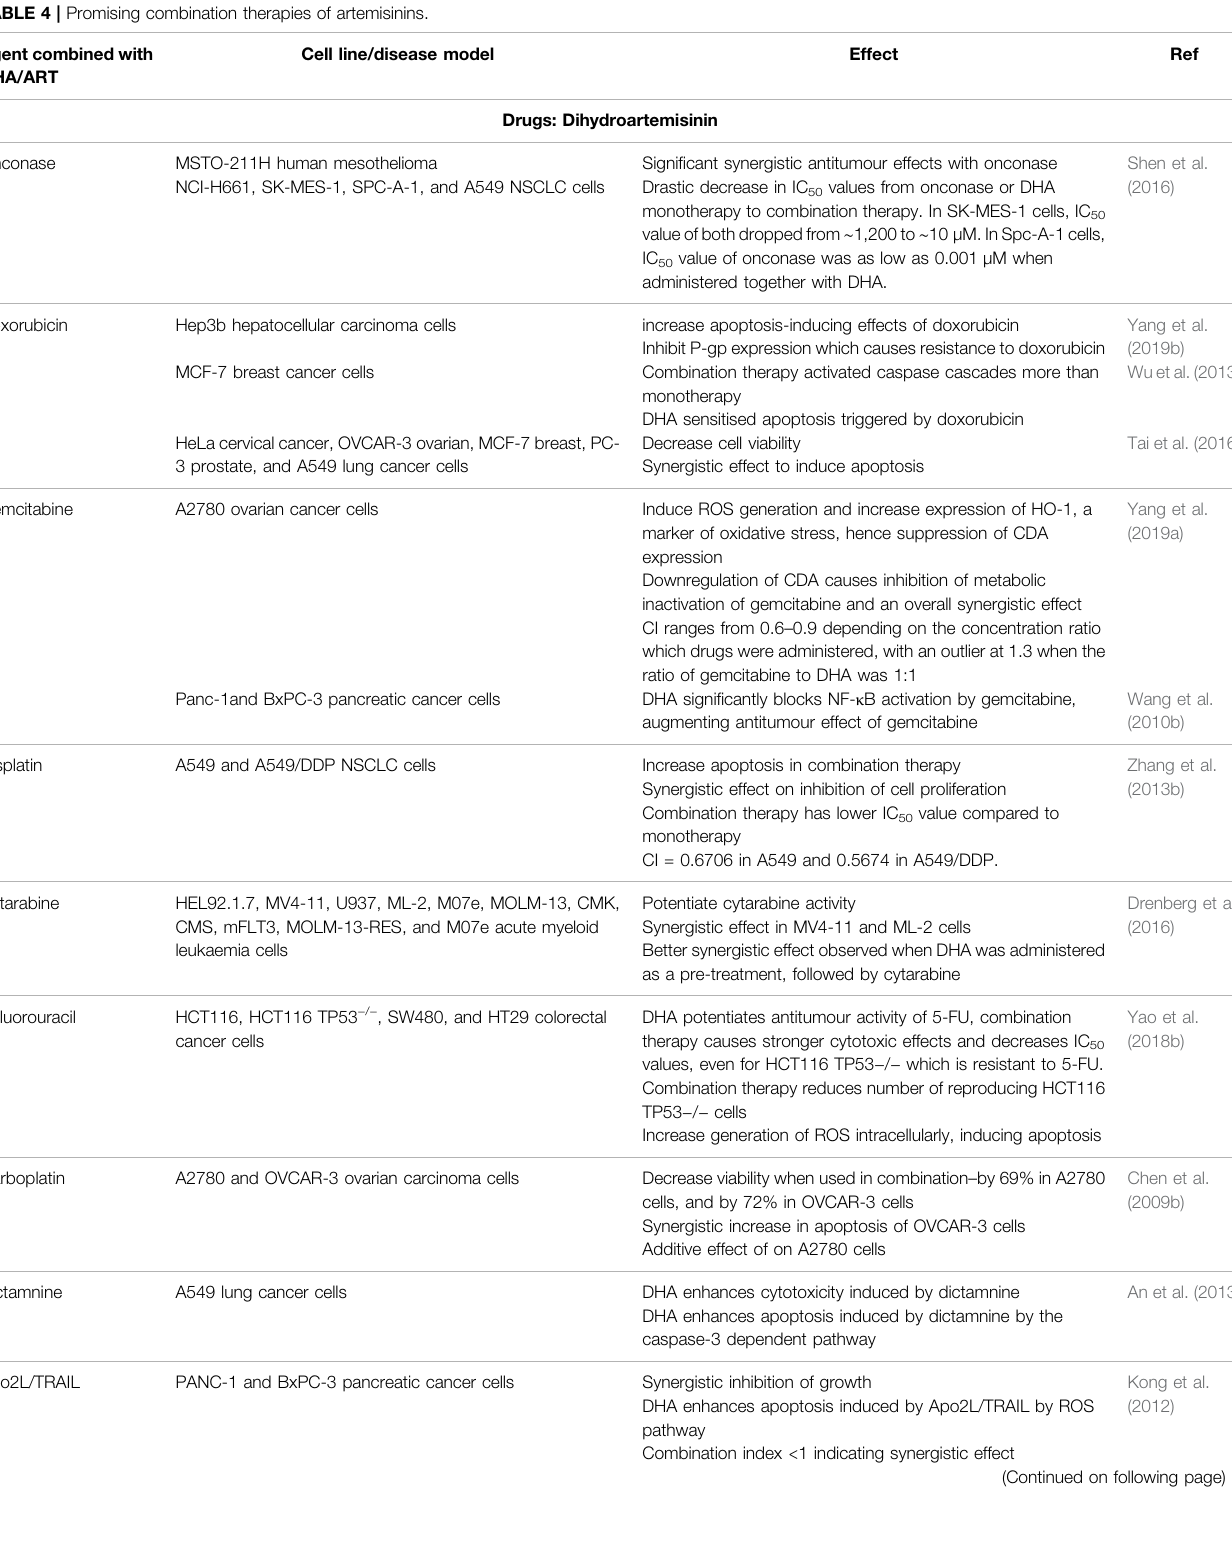
TABLE 4 | Promising combination therapies of